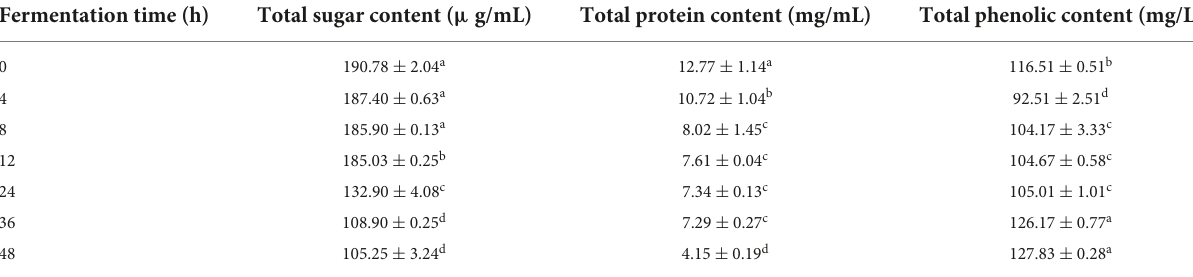
TABLE 2 Total sugar, total protein and total phenolic content of Ginkgo biloba kernel juice fermented by strain Y2. Fermentation time (h)